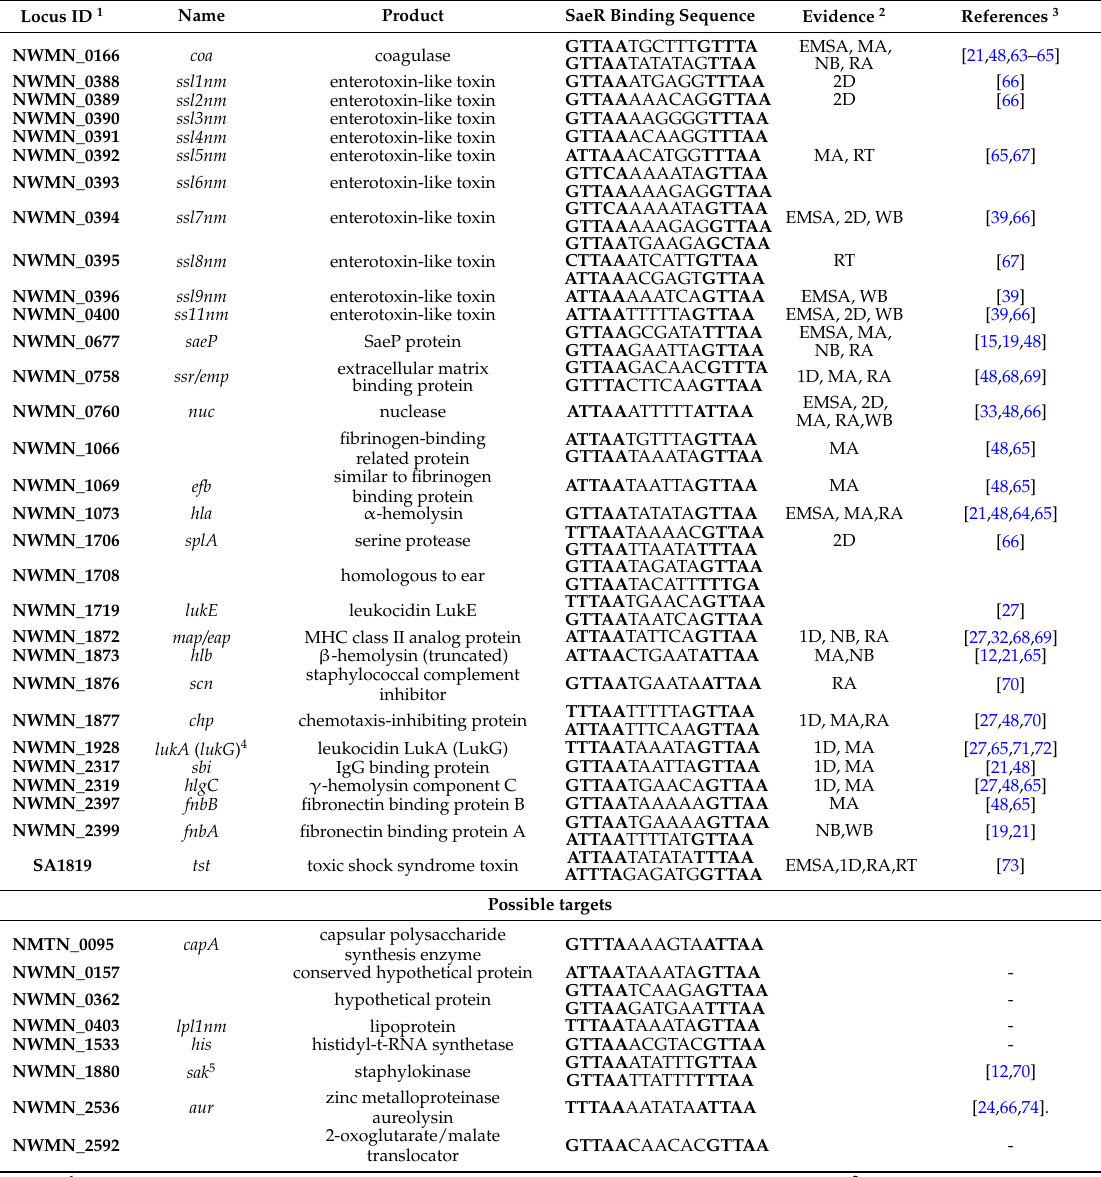
Table 1. Direct targets of the SaeRS